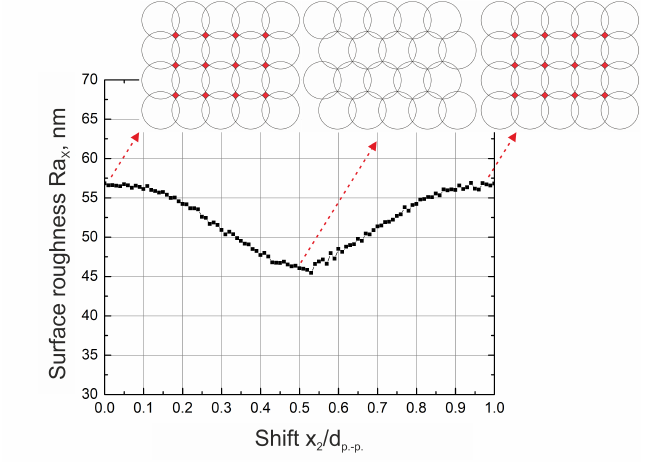
Figure 10. Surface roughness dependence on the shift of every 2nd line when pulse distance of 32 µm is maintained. On the x -axis, the shift between consecutive lines x 2 divided by the pulse distance is plotted. Used laser system—number 1. Surface roughness in x direction. Data of numerical